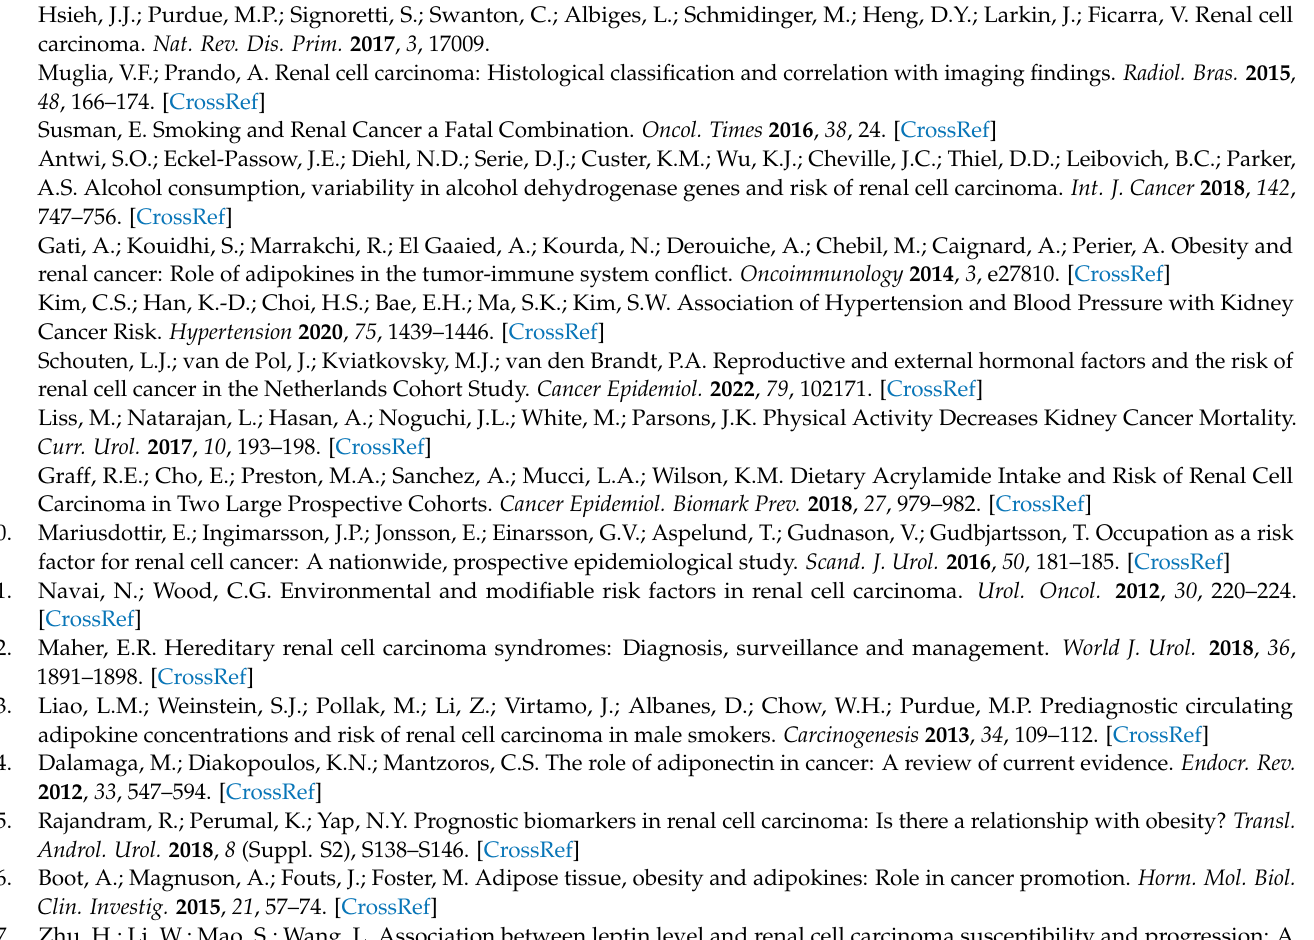
Table S2: ARRIVE guideline; Table S3: Quality assessment tools for in vitro studies adapted from